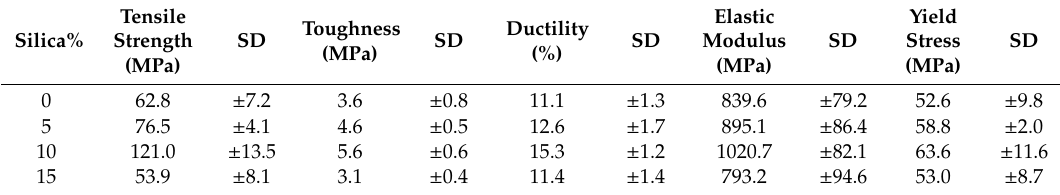
Table 1. The mechanical properties of the PLA / silica mixture with standard deviation